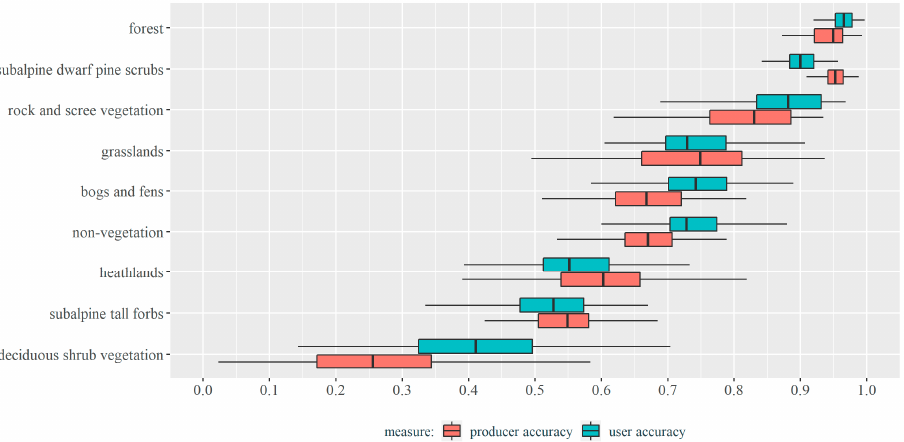
Figure 4. Producer and user accuracies obtained during the 100-times iterative procedure of accuracy assessment for the best dataset.